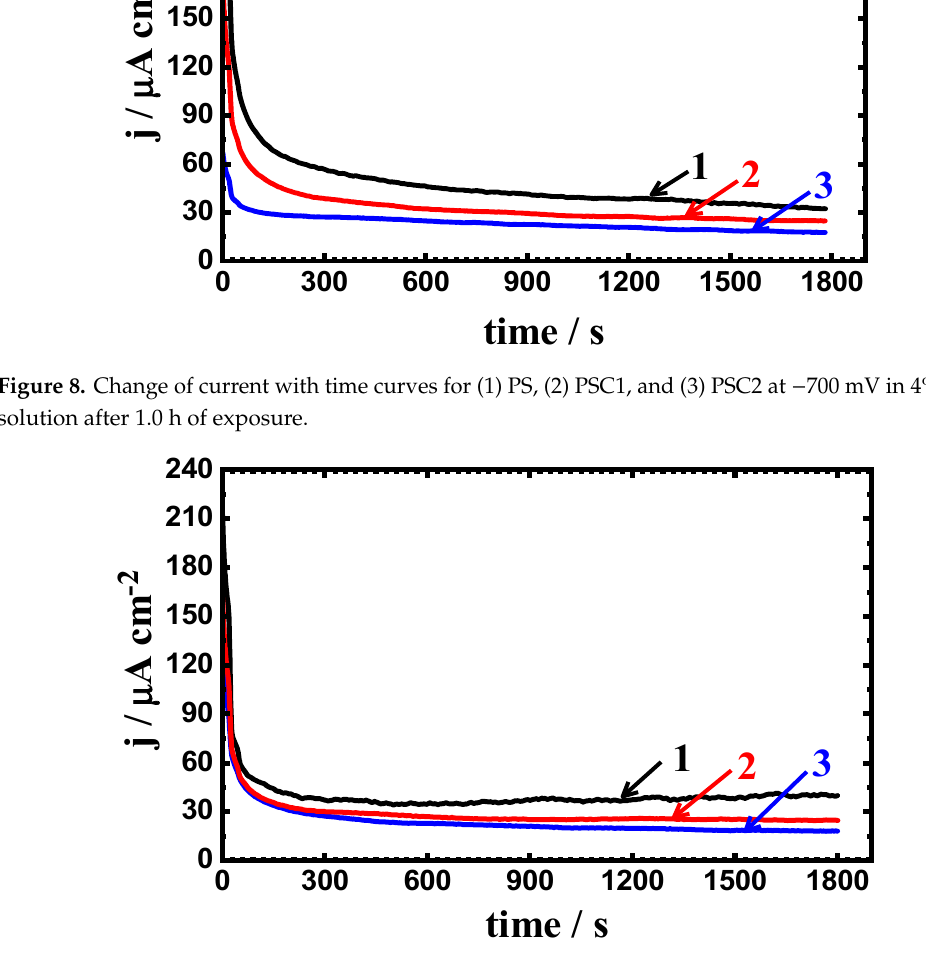
Figure 9. Change of current with time curves for (1) PS, (2) PSC1, and (3) PSC2 at − 700 mV in 4% NaCl solution after 24 h of exposure.